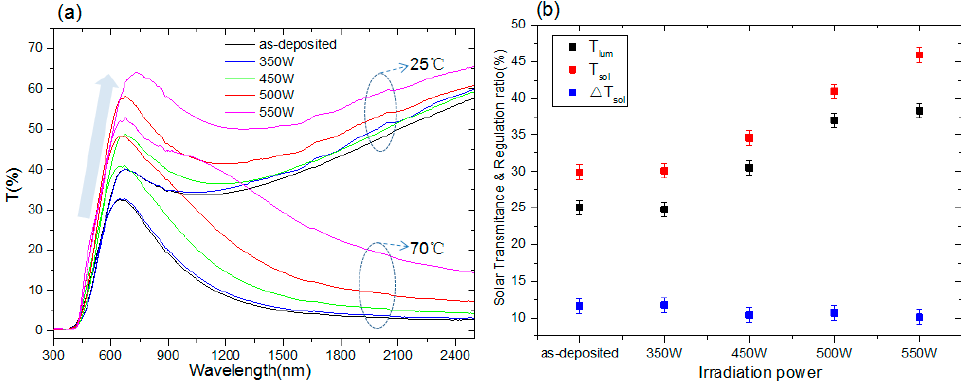
Figure 6. ( a ) The optical transmittance spectra of VO 2 films bombarded with Ar/O plasma were measured at 25 °C and 70 °C using a spectrophotometer for both insulating and metallic states; ( b ) solar transmittance of T lum , T sol , and solar regulation ratio △ T sol in VO 2 films after Ar/O plasma